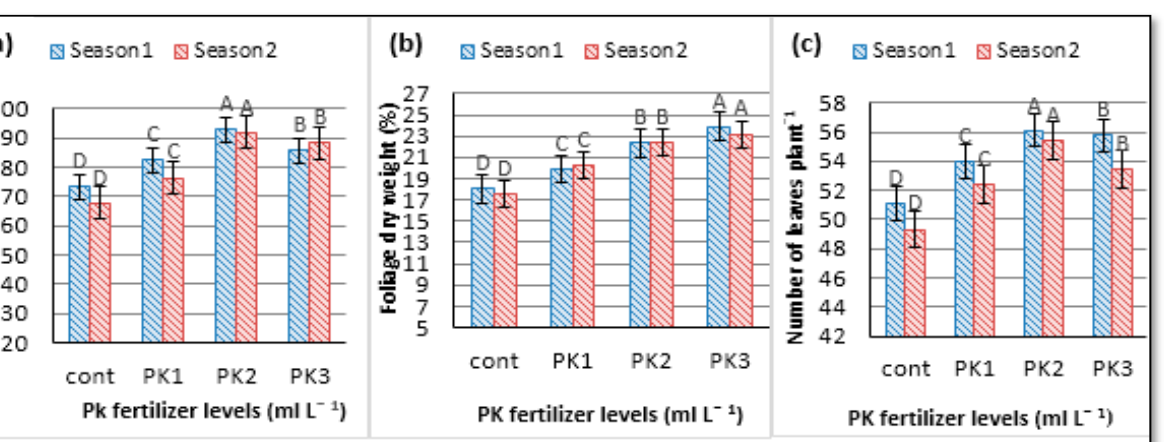
Figure 1. Vegetative growth parameter (means ± SE) of the globe artichoke as affected by the application of PK fertilizer levels (Control: without, PK 1 : 25, PK 2 : 50 and PK 3 : 75 mL L − 1 ) on ( a ) Plant height (cm); ( b ) Foliage dry weight (%) and ( c ) Number of leaves per plant. Letters in the figures indicate that the mean ± SE treatments with the same letters were not significantly different according to Duncan’s multiple range test for p < 0.05.